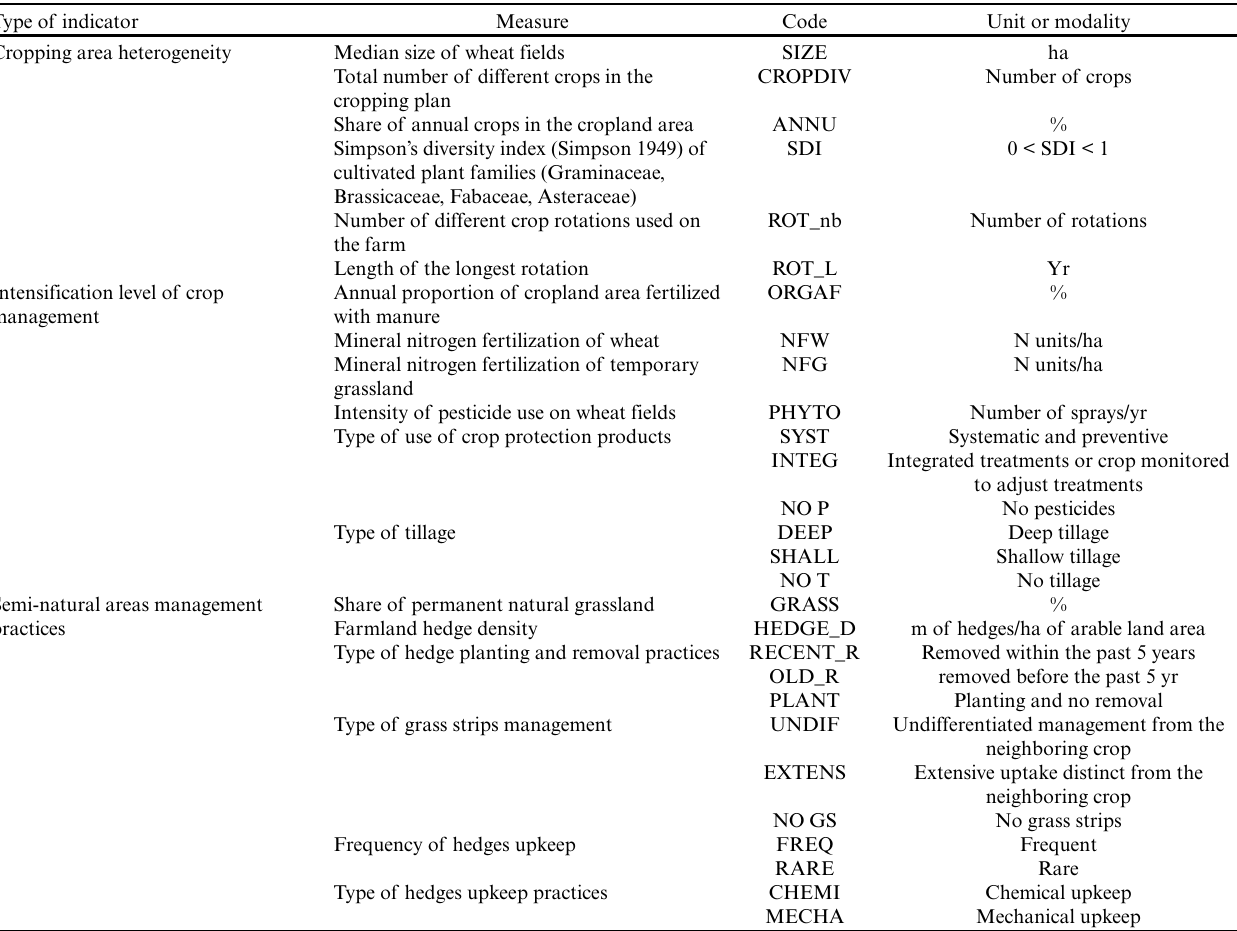
Table 1. Land management practices